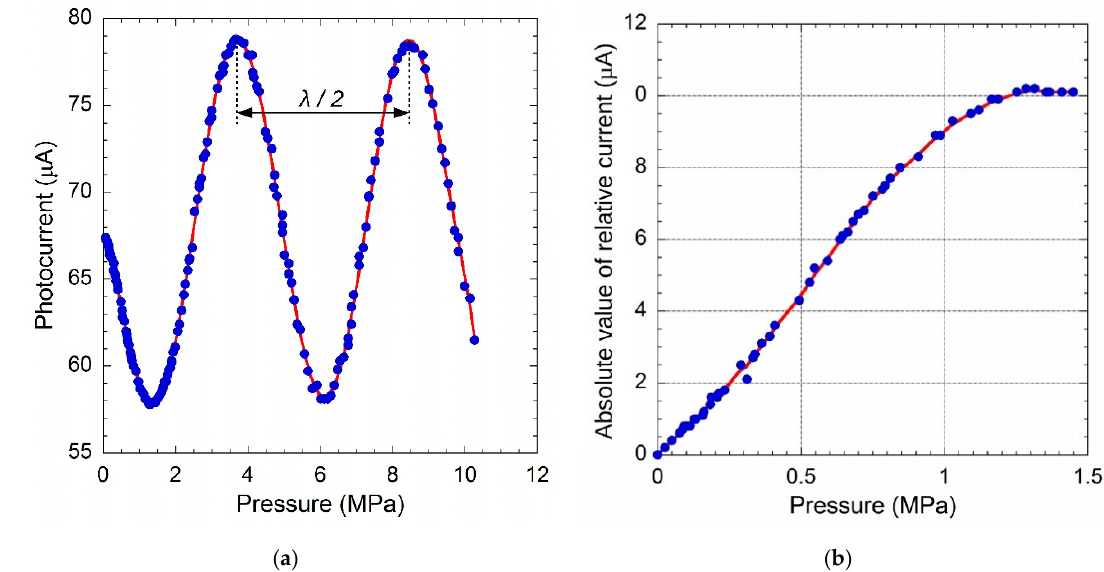
Figure 7. Photocurrent signal as a function of the applied pressure acquired for a 160 µm thick S-SiC diaphragm. ( a ) In the 0–10 MPa range the expected sinusoidal behavior stated by Equation (1) is clearly found. The period of signal corresponds to a λ / 2 = 775 nm deflection of membrane. ( b ) The plot shows the absolute value of the relative photocurrent change obtained subtracting the value acquired at 0 Pa. In the investigated 0–1 MPa range sensor non-linearity is around 4%.